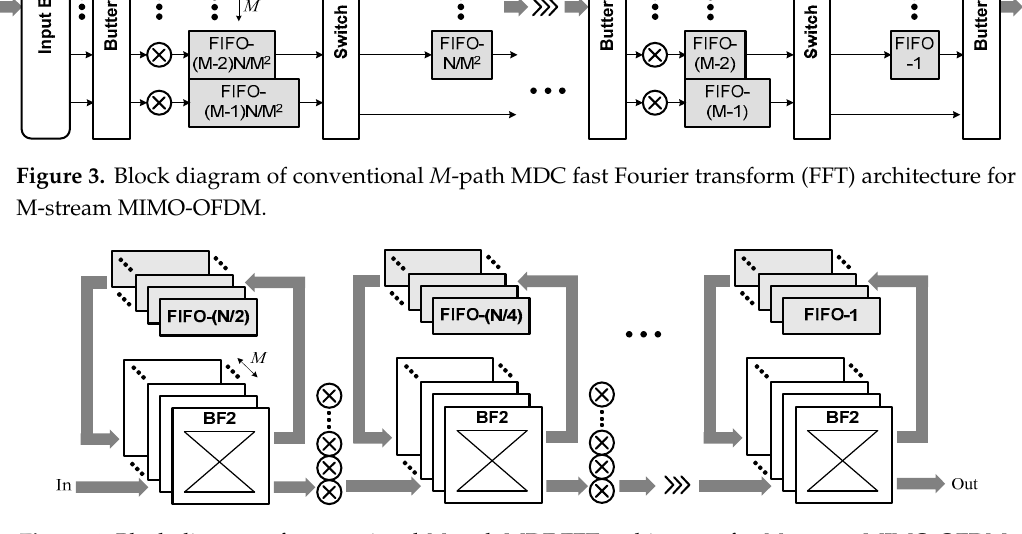
Figure 4. Block diagram of conventional M -path MDF FFT architecture for M -stream MIMO-OFDM.